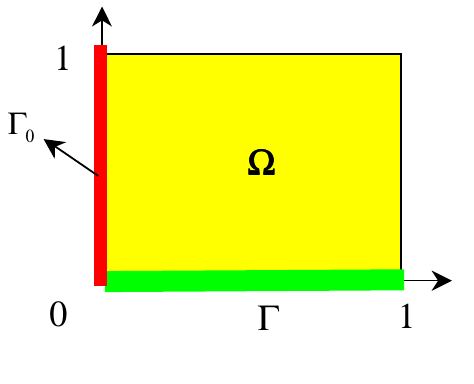
Figure 3. Domain Ω , region Γ and location Γ